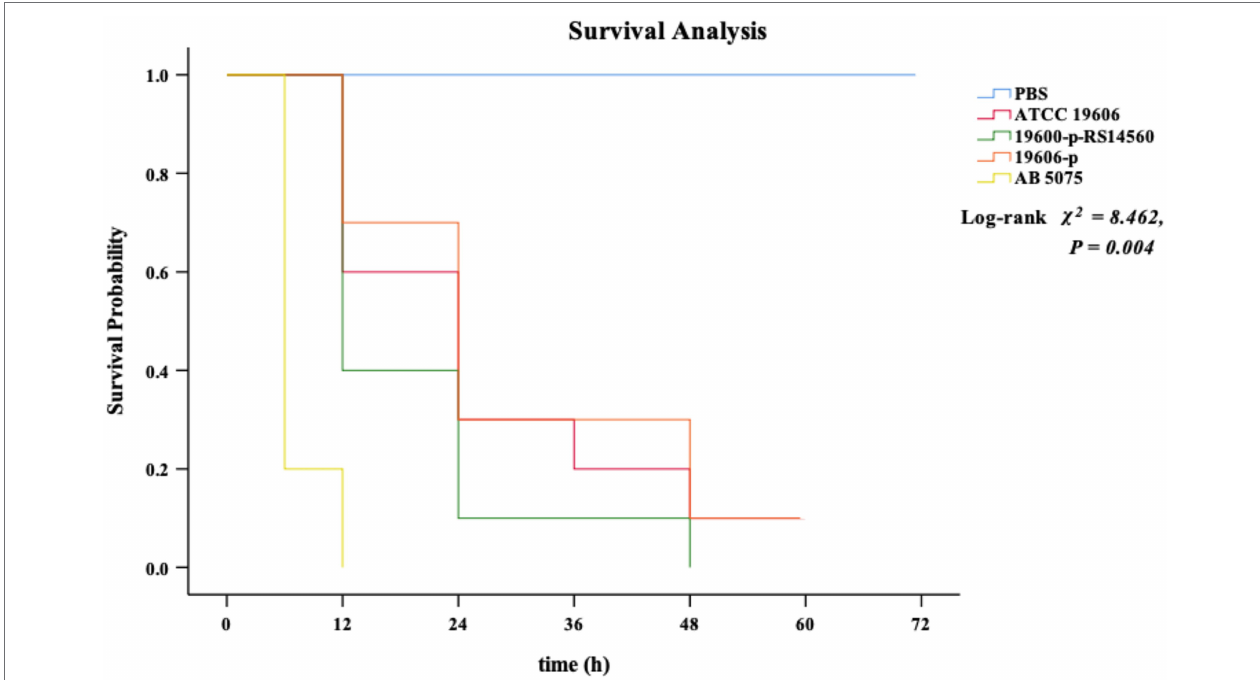
FIGURE 4 | Kaplan–Meier curve analysis of the survival of G. mellonella after infection. PBS is the negative control group, ATCC 19606 is the wild-type strain, 19,606-p-RS14560 is the overexpression strain, 19,606-p is the empty plasmid control group, and A. baumannii 5075 is the positive control group. PBS, phosphate buffered saline. p < 0.05 indicates a statistical